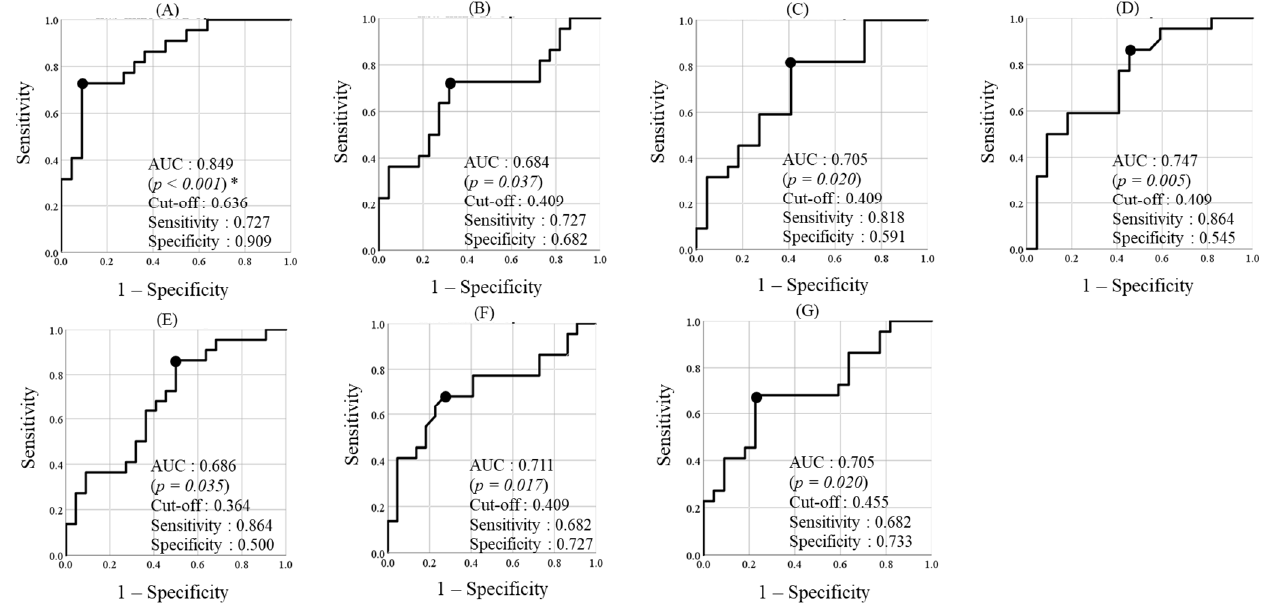
Figure 3. Receiver operating characteristic (ROC) curve analysis for the discriminatory power of miRNAs for the progression and control groups. ROC curves for hsa-miR-5571-5p ( A ), hsa-miR-17-3p ( B ), hsa-let-7f-5p ( C ), hsa-miR-99a-5p ( D ), hsa-miR-200a-3p ( E ), hsa-miR-28-5p ( F ), and hsa-miR-320d ( G ) are shown based on the relative expression ratio. Sensitivity, specificity, and cut-off values were optimized using the maximum Youden index. The solid line with the black circle shows the plot with these optimized values. * non-parametric test for the area under the curve (AUC).